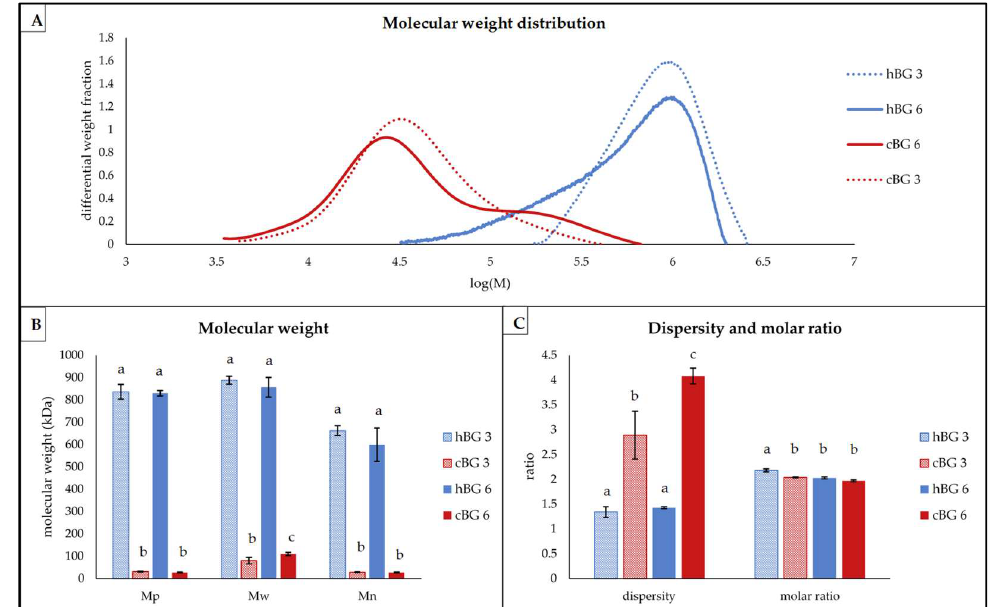
Figure 4. Structural characteristics of β-glucan (BG) present in breads fortified with 3% of high molar mass BG or control BG (hBG 3 or cBG 3) and 6% of high molar mass BG or control BG (hBG 6 or cBG 6) presented as: ( A ) molar mass distribution shown as differential weight fraction plotted against the logarithmic molar mass (M); ( B ) peak- (M p ), weight average- (M w ) and number average (M n ) molar mass; ( C ) dispersity and molar ratio. All values are shown as mean ± standard deviation ( n = 3, p < 0.05). Different lower-case letters indicate a significant difference between the breads for each characteristic.